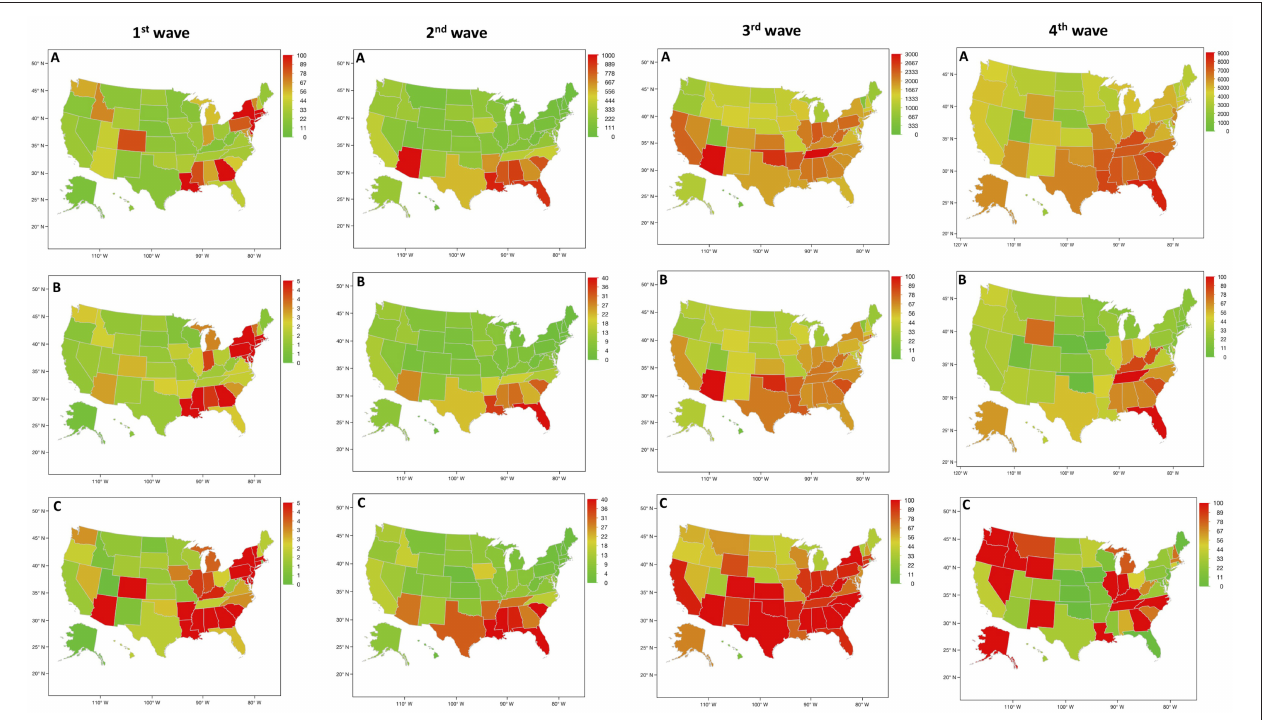
FIGURE 1 | Count of new cases of COVID-19 patients across the USA for the four waves (new cases were reported by states divided by the population of each state and per 100.000 inhabitants). (A) New cases between the minimum of infection counts and the national peak time between two waves. (B) Rolling 7-day average before the national peak time of each wave. (C) Incidence of new cases for the national peak time of each